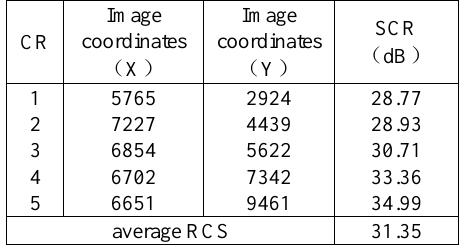
Figure.4 Sinc Function Antenna Pattern Fitting Graph